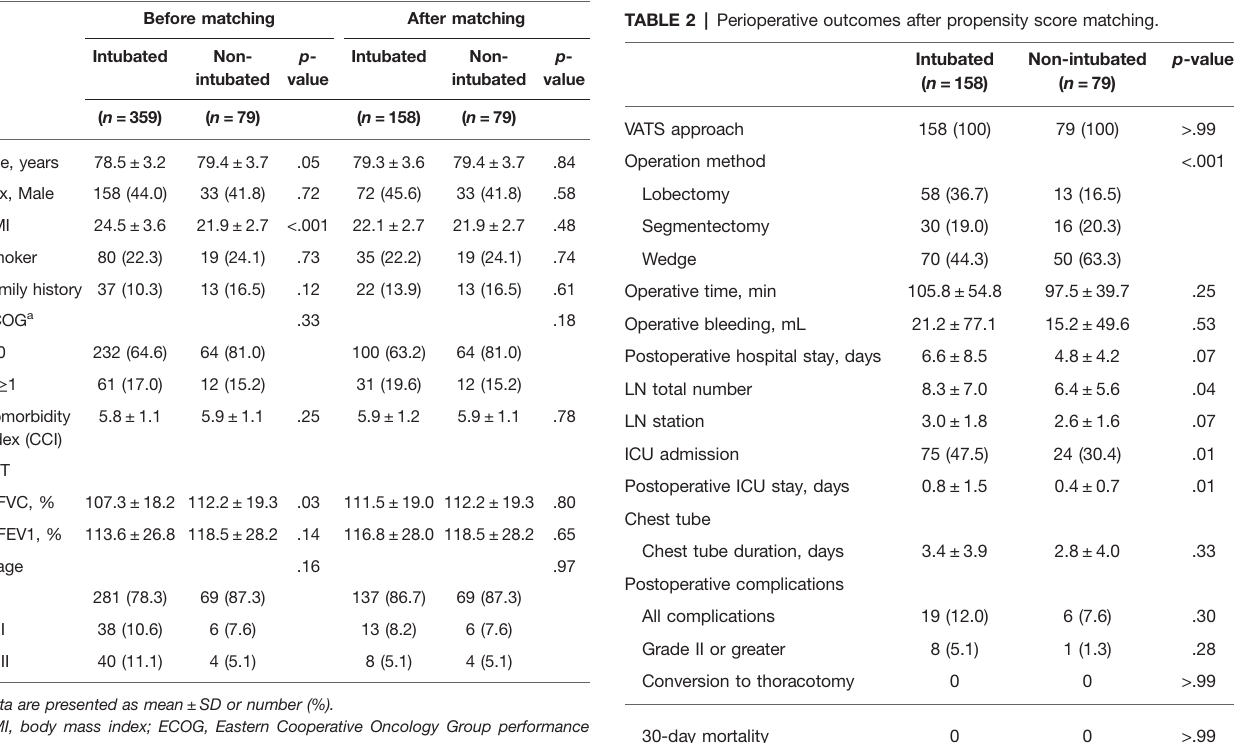
Table 2 . All surgeries were performed via video-assisted TABLE 1 | Demographic and clinical features after propensity score